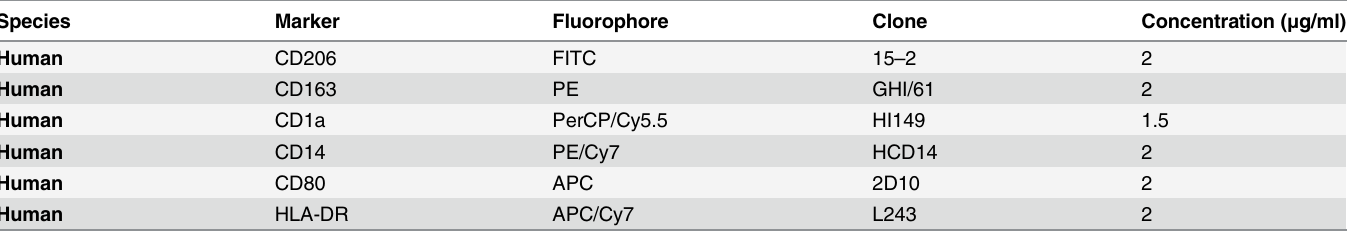
Table 1. Antibody/fluorophore conjugates used for multi-color flow cytometry. All antibodies were monoclonal and purchased from BioLegend.